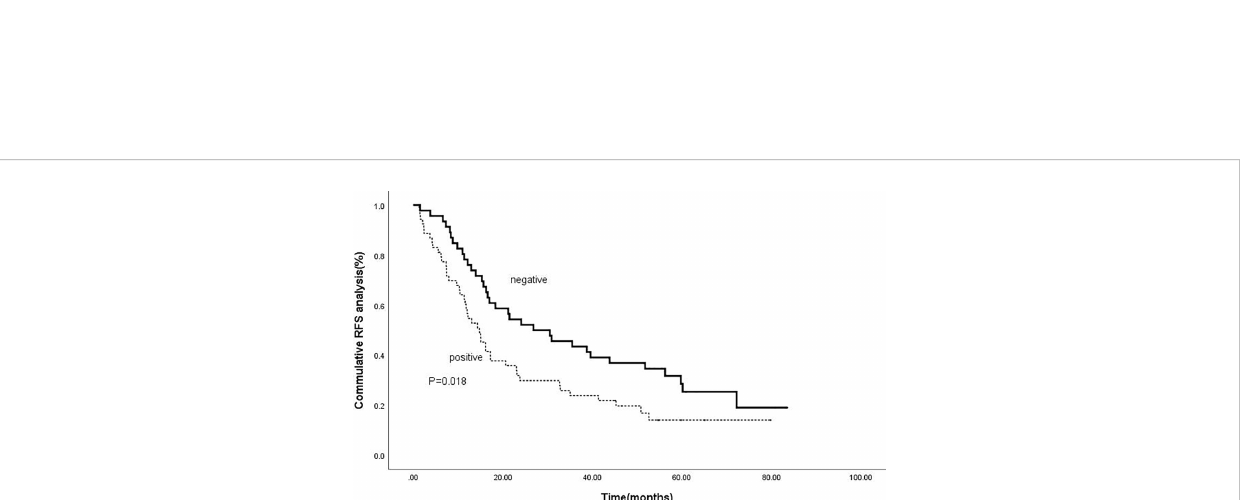
FIGURE 3 Comparison of RFS based on intrahepatic HBsAg. The cumulative 1-, 3-, and 5-year RFS rates for patients with negative HBsAg expression after combined therapy were 78.3%, 43.5% and 30.4%; while for patients with positive HBsAg expression were 58.5%, 24.5% and 17.0%, respectively